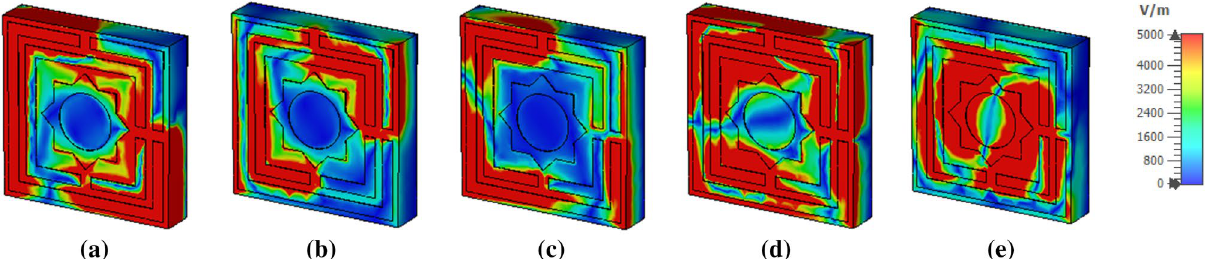
Figure 11. Electric field distribution at ( a ) 3.80 GHz, ( b ) 5.65 GHz, ( c ) 8.45 GHz ( d ) 10.82 GHz and ( e ) 15.92